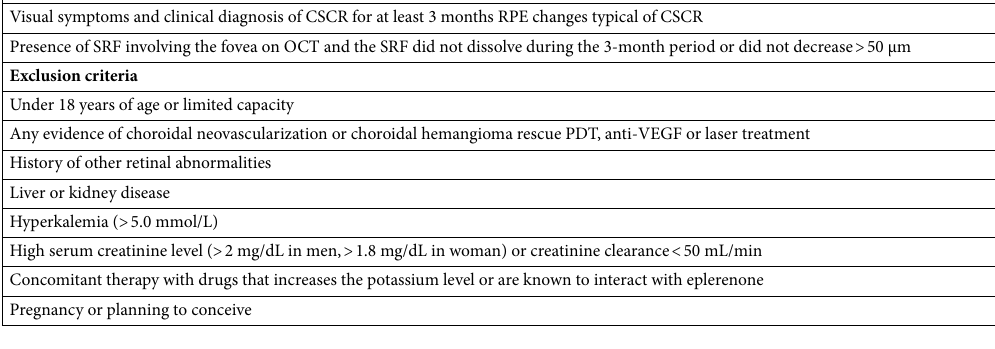
Table 1. Patient recruitment